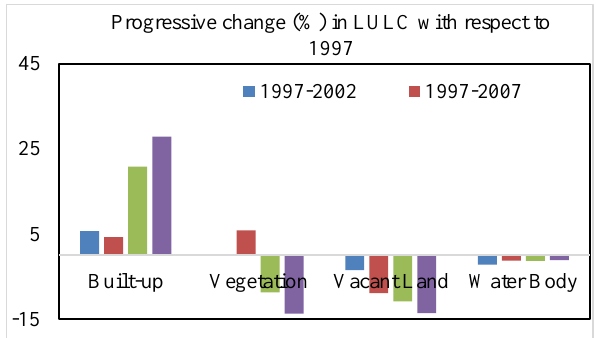
Figure 2. LULC Change (%) with Respect to 1997